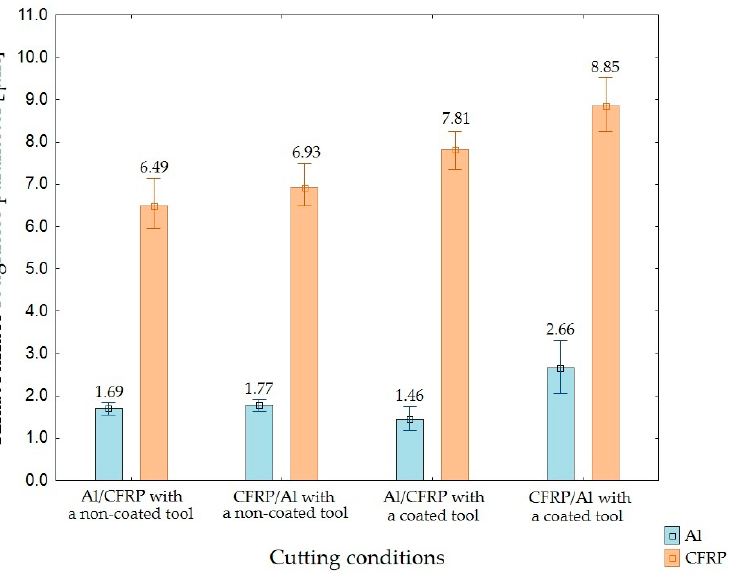
Figure 8. Values of Rmax surface roughness parameter depending on the machining configuration and the type of tool.